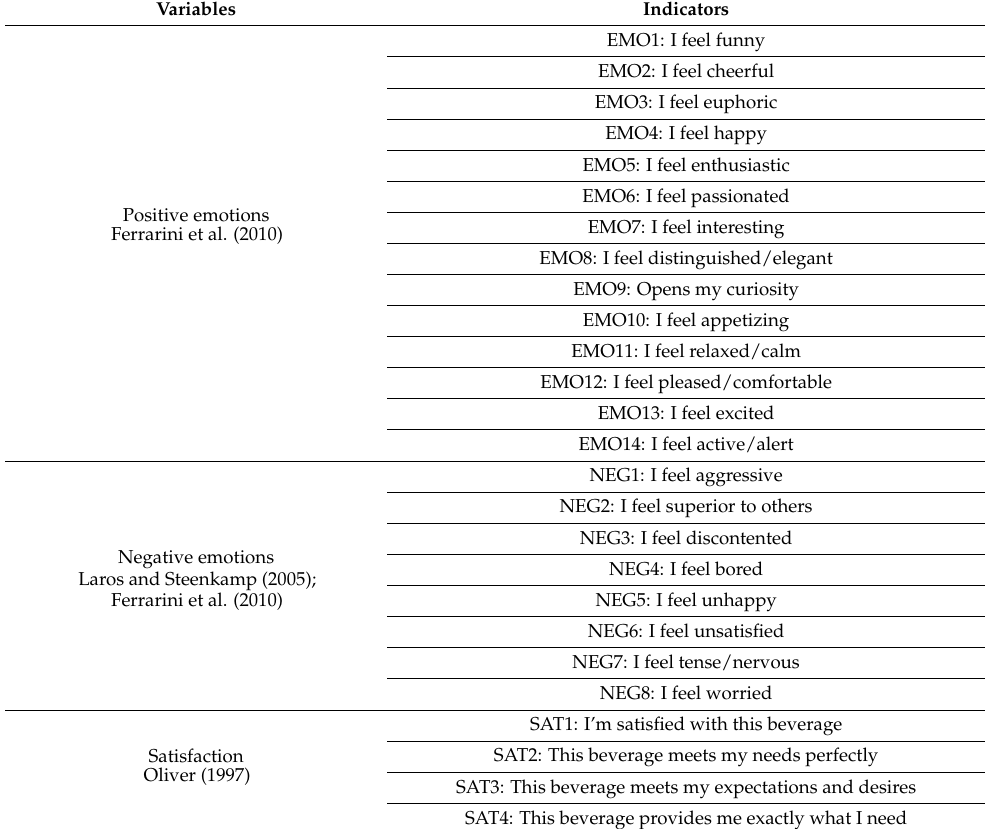
Table 1. Variables and